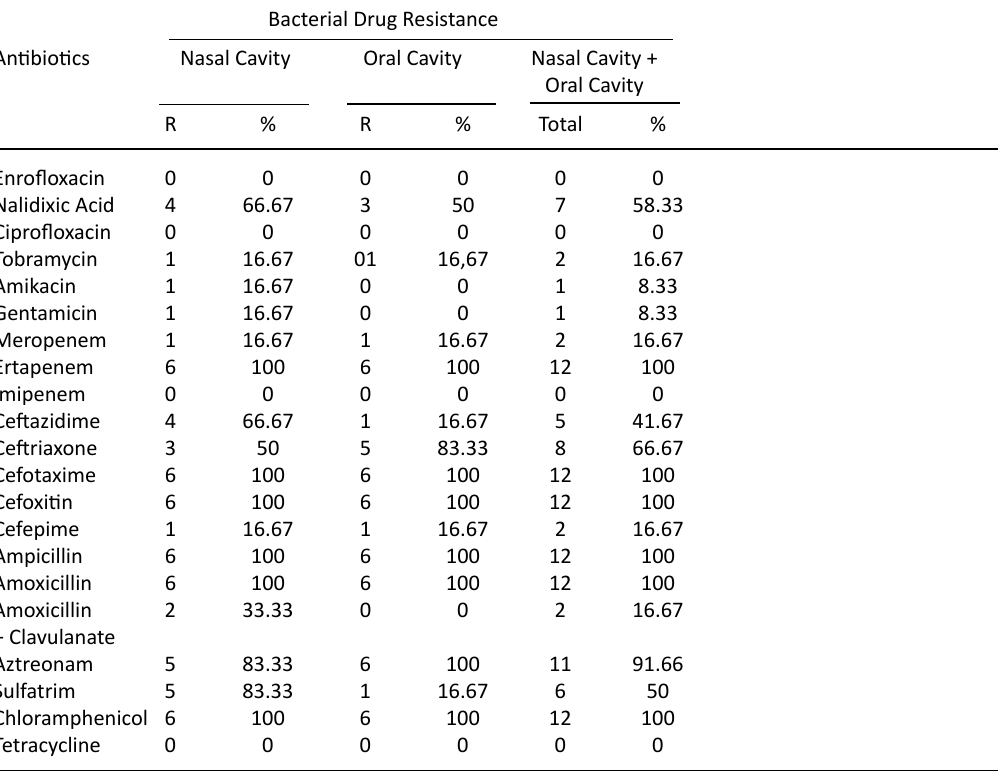
Table 2. Resistance profiles of bacterial isolates belonging to the Enterobacteriaceae family from nasal and oral cavity swabs of horses used for animal traction in the municipality of Umuarama, Parana, Brazil,